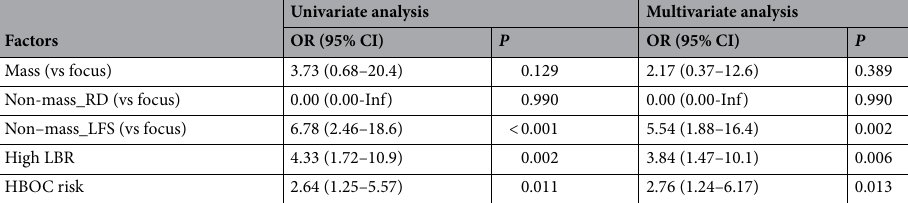
Table 3. Logistic regression analysis for predicting malignancy. CI, confidence interval; HBOC, hereditary breast and ovarian cancer; LBR, lesion-to-background ratio; LFS, linear, focal and segmental distributions; OR, odds ratio; RD, regional and diffuse